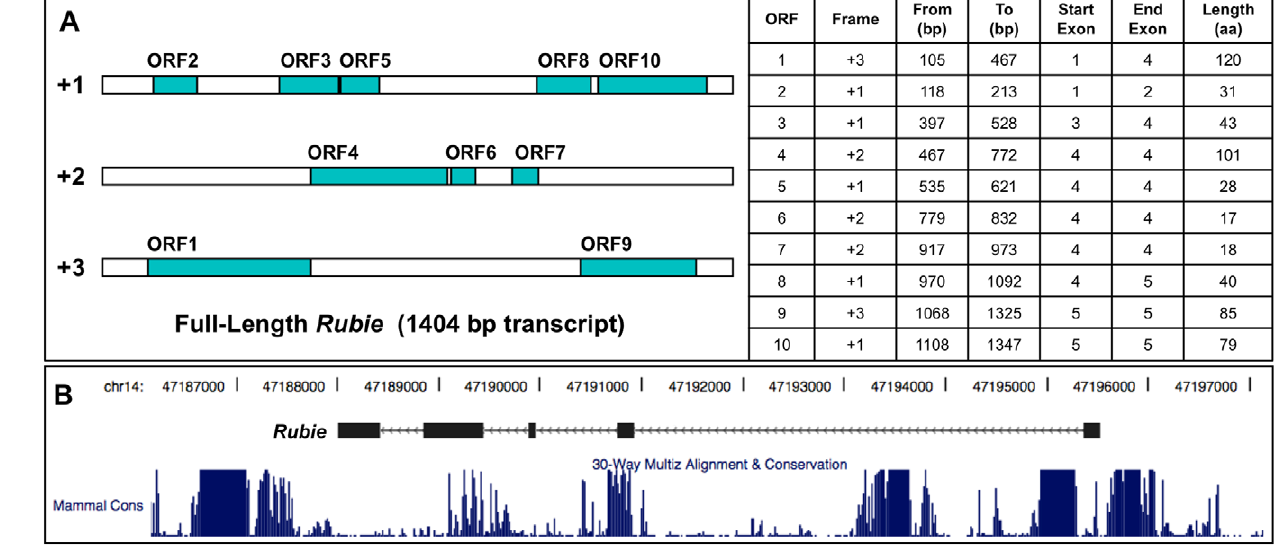
Figure 4. Rubie exhibits features of a long, non-coding RNA. (A) Rubie contains ten potential open reading frames longer than 50 bp. The longest (ORF1) would encode a 120 amino acid (aa) protein, but is only present in mice from the C57 lineage. Other strains have a termination codon in exon 2, which truncates the ORF at 45 aa. (B) The mammalian conservation track of the UCSC Genome Browser (http://genome.ucsc.edu/) shows that the exon sequence of Rubie is poorly conserved across species. CSS-14 mice with the Chr14 SWR/SWR genotype (Figure 5C and